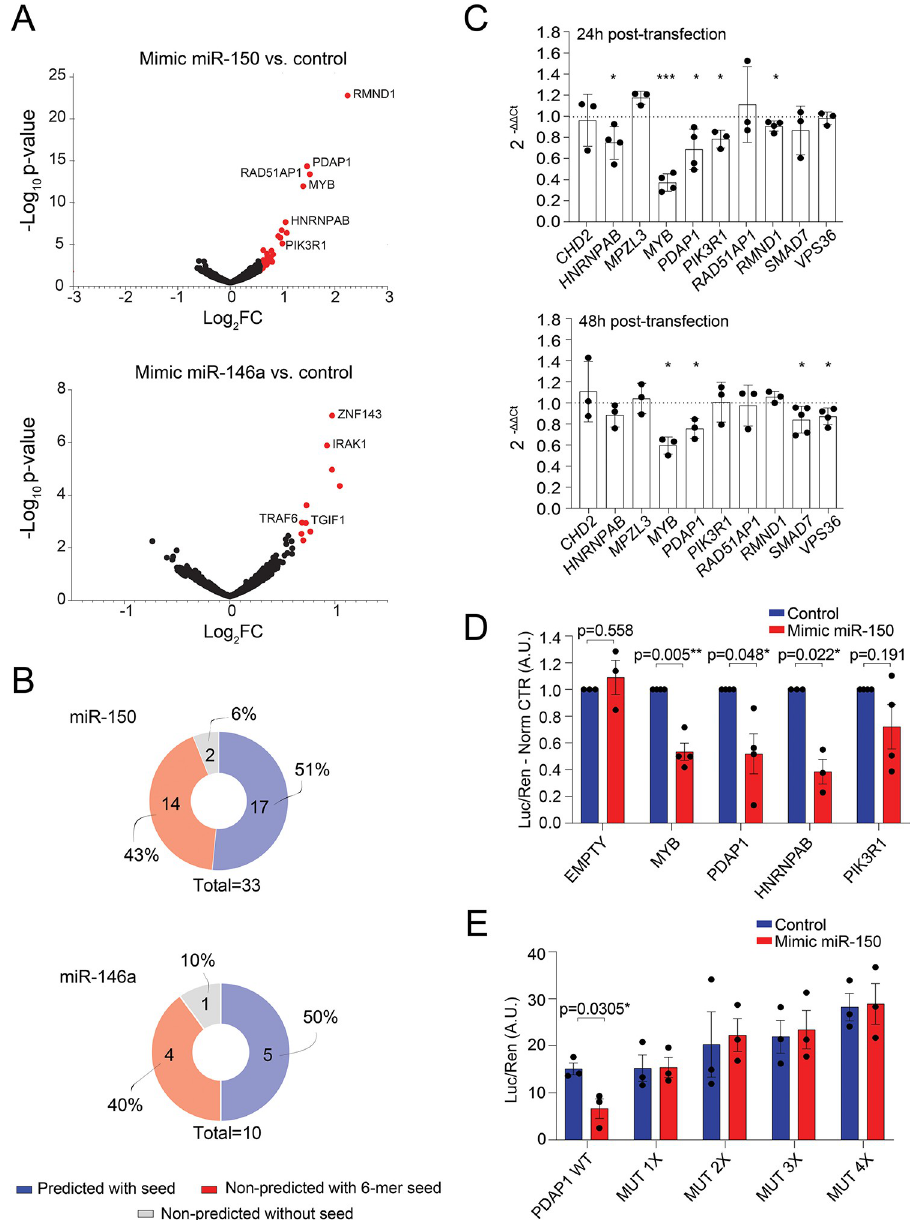
Fig 2. Identification of miR-150 targets. (A) Volcano plot of differentially expressed genes between the indicated miRNA mimic and control oligonucleotides. Genes in red were considered significantly differentially expressed when log 2 FC � 0.6, − log 10 p -value � 2. (B) The list of genes obtained from (A) was intersected with several prediction databases using miRWalk 2.0. Both the 3 0 UTRs and the CDS were manually searched for the presence of at least a 6-mer miR-150 or miR-146a binding site. (C) Activated memory cells were transfected with miR-150 mimic or control oligonucleotide. Twenty-four hours or 48 hours after transfection, the expression of the indicated genes was measured by RT-qPCR. N = 3 to 5 independent donors. Mean ± SD. Student t test, 2 tailed, paired. (D) The 3 0 UTR of the indicated genes was cloned in a dual-luciferase reporter vector and transfected into HEK293 cells together with either a miR-150 mimic or a control oligonucleotide. Luciferase reads were normalized to the renilla ones. N = 3 to 4 independent experiments. Mean ± SEM. Student t test, 2 tailed, paired. (E) Same as in (D), except that the 4 putative miR-150 binding sites identified in the PDAP1 3 0 UTR were mutated by site-directed mutagenesis. N = 3 independent experiments. Mean ± SEM. Student t test, 2 tailed, paired. Underlying data can be found in S1 Data. A.U., arbitrary unit; CDS, coding sequence; FC, fold change; miRNA, microRNA; RT-qPCR, reverse transcription quantitative PCR; UTR, untranslated region; WT, wild-type.